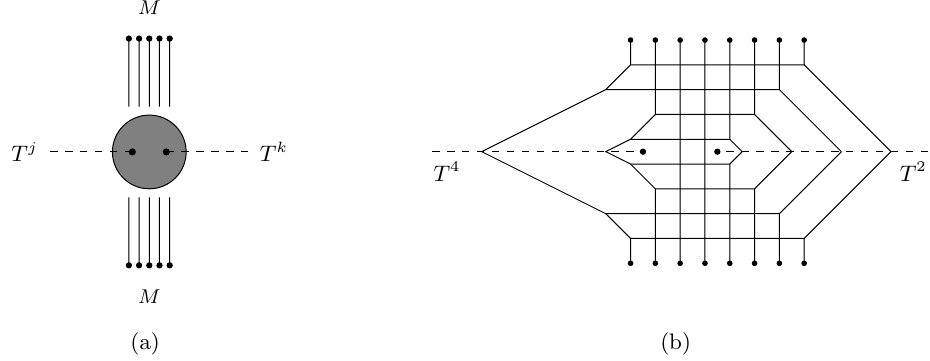
Figure 6 . The + N;M;k;j 5-brane junction with the 7-branes moved into the intersection on the left hand side. On the right a gauge theory deformation with N = M = 8, j = 4, k =